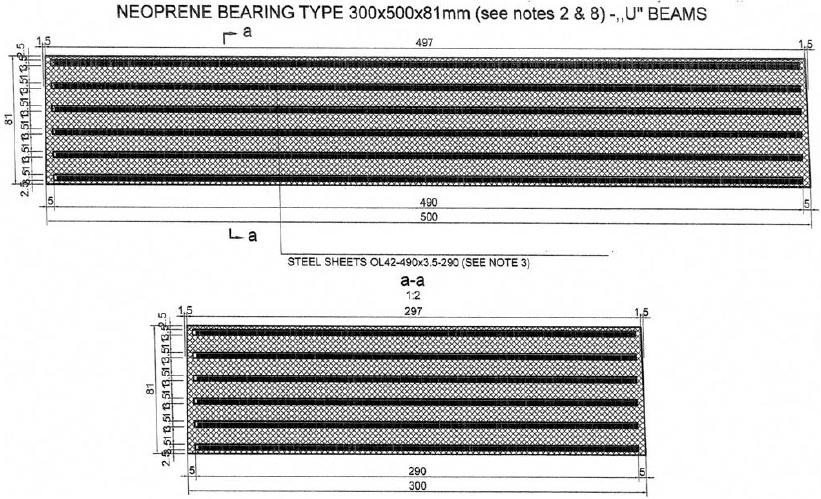
Fig. 3. Neoprene bearing details.